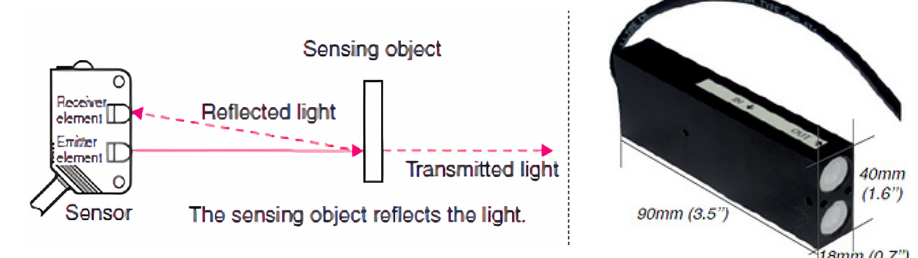
Figure 5. Eco Counter PIR sensor with a combined emitter and